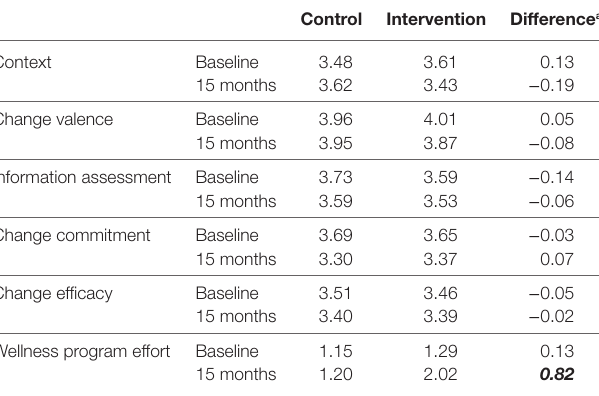
Table 5 | Differences between intervention and control sites in organizational readiness to change and wellness program effort for baseline and 15-month results.